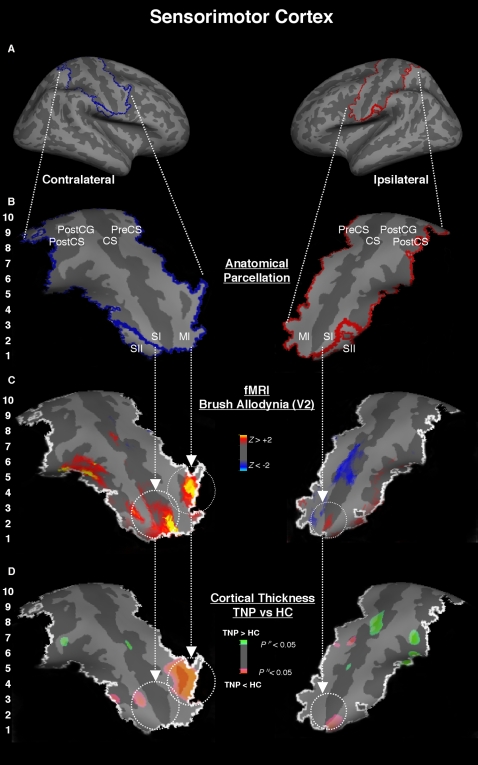
Somatosensory (SI & SII) and Motor (MI) Cortices.
Panels A and B - SI and MI in this study were defined as the central sulcus including its posterior wall, and the precentral gyrus, respectively. SII was defined was the subcentral section lateroventral to the postcentral gyrus. In the hemispheres contralateral and ipsilateral to the TNP, regions of the sensorimotor cortex were segmented in ten equal vertical sections labeled from bottom to top in an ascendant manner, being section 1 located in the lowest portion, and section ten in the highest.; Panel C - Average BOLD deactivations (dark-light blue) and activations (red-yellow) in the sensorimotor cortex during allodynic brush of the affected V2 of the six TNP patients. The functional clusters were located in the most caudal region of SI and MI where the face and the neighboring regions are somatotopically represented; Panel D – Differences in cortical thickness between TNP and HC along sections of the sensorimotor cortex (pink = TNP<HC; green = TNP>HC). There is bilateral thinning in the most caudal region of the somatosensory cortex, where the face is represented, which was colocalized with functional clusters during allodynic pain.